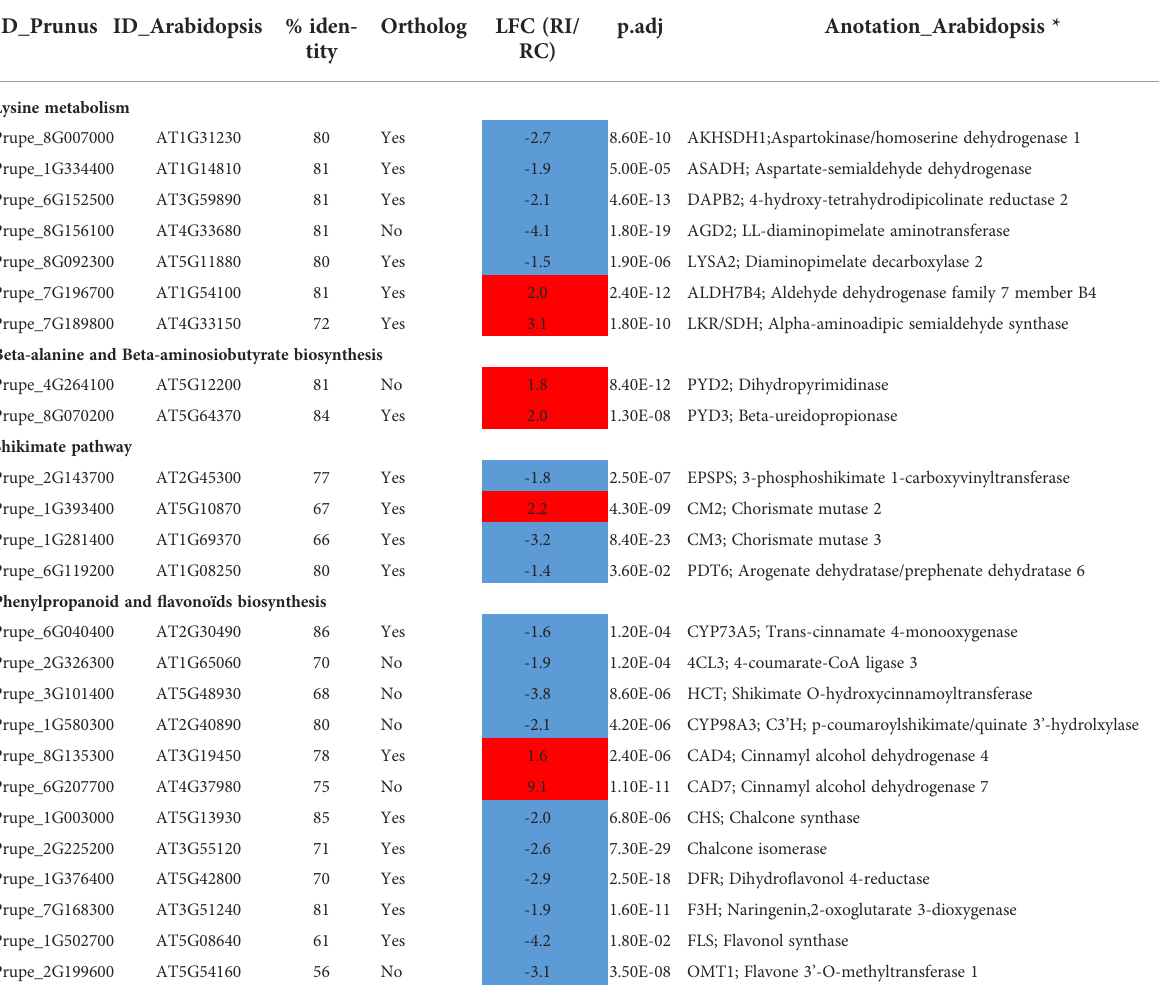
extracellular domain that perceives stimuli and an intracellular domain transmitting information to several cytoplasmic protein kinases subfamilies: mitogen-activated protein kinases (MAPKs), calcium-dependent protein kinases (CPKs) and calcineurin B-like proteins (CBLs) (Kurusu et al., 2010;